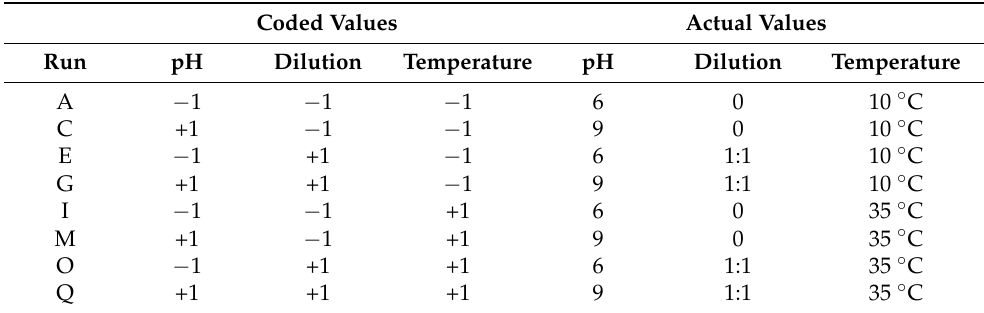
Table 1. Combinations of the